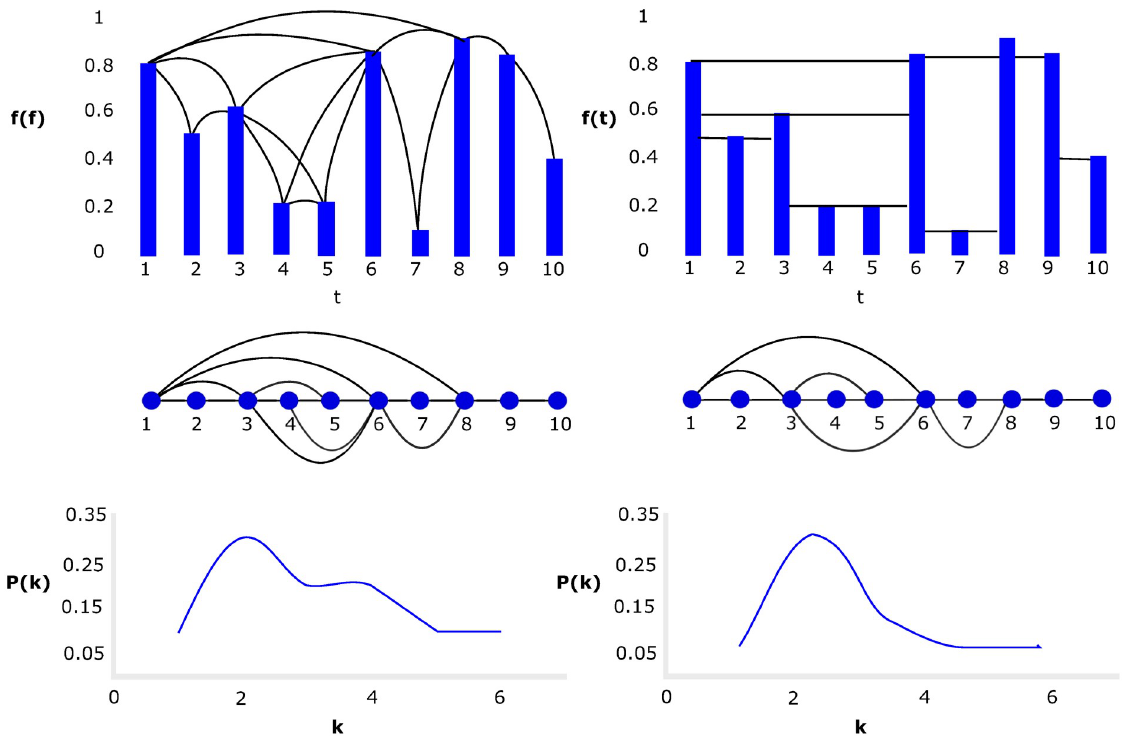
Fig 1. From time series to networks. Mapping a time series to a network using NVA (left) and HVA (right). The figure shows the time series with a solid line if there is visibility (link) between the indicated points. The generated network and its degree distribution are shown. It is observed that NVA has more connections than HVA by the visibility